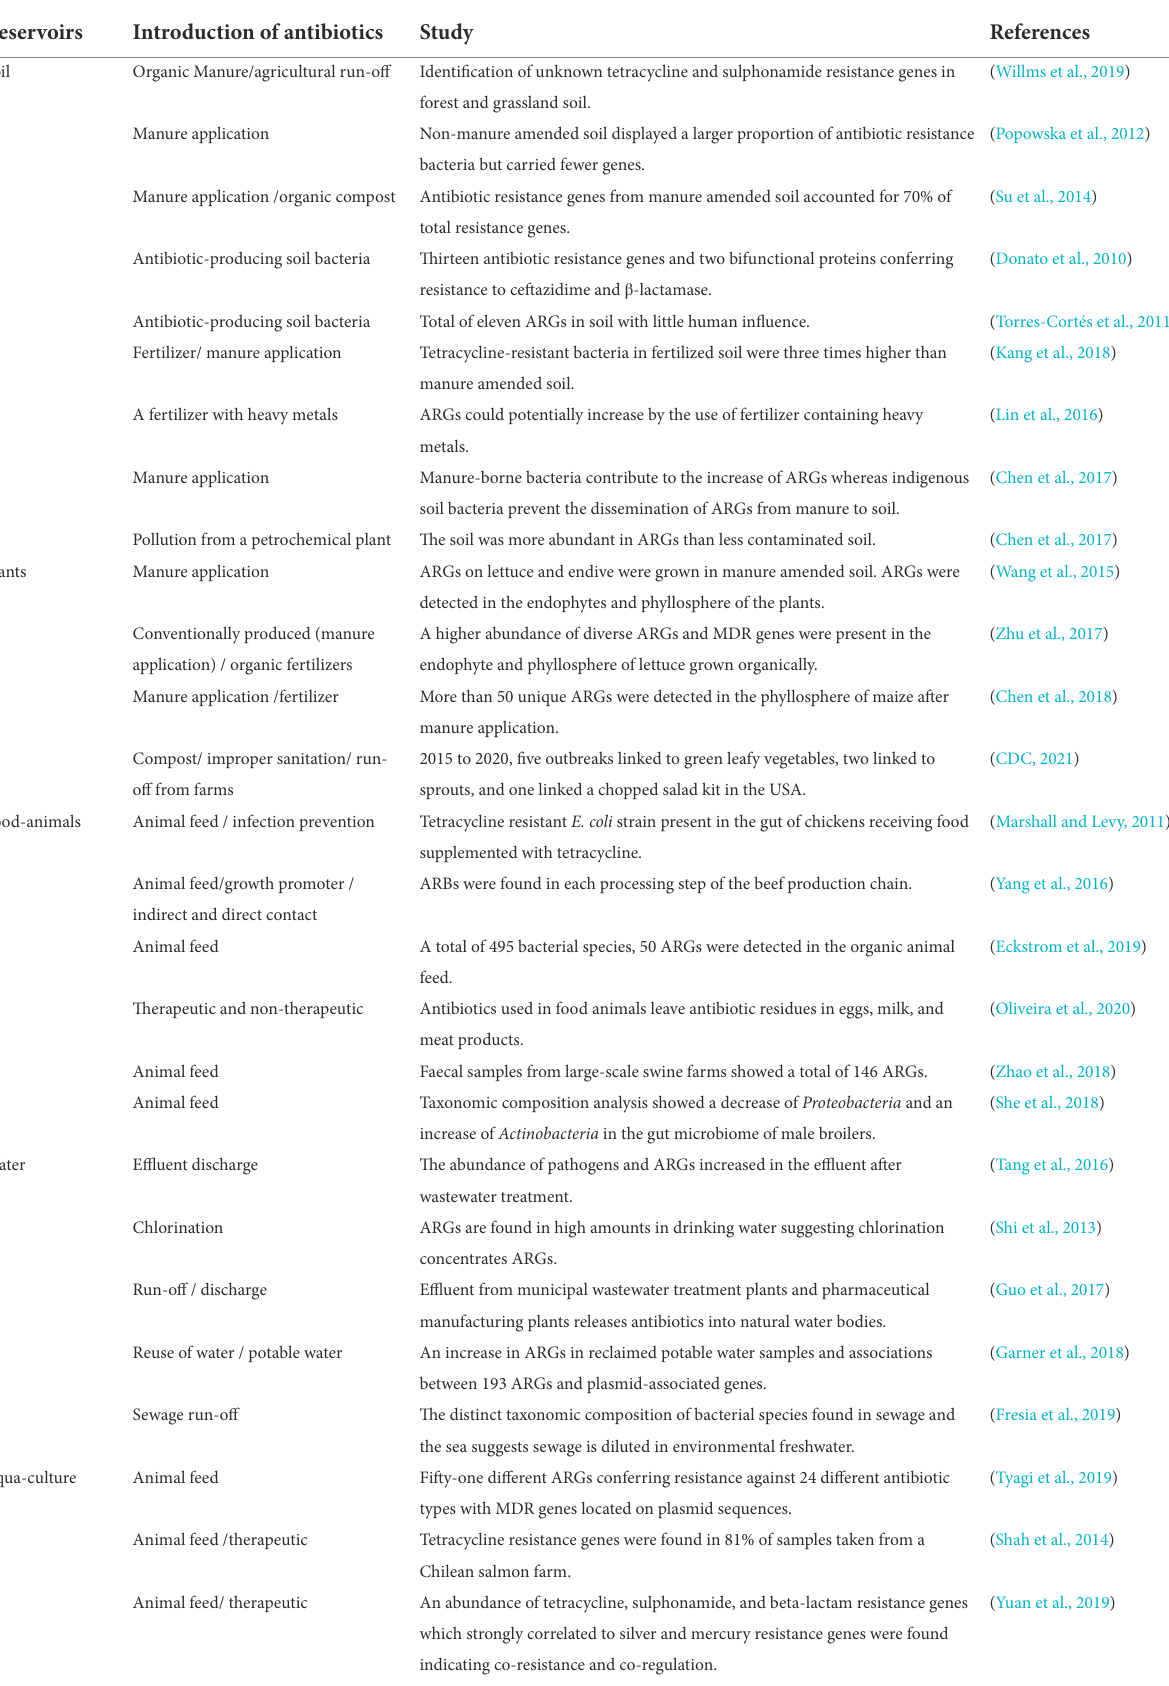
TABLE 5 Studies focusing on the introduction of antibiotics and AMR in each non-clinical